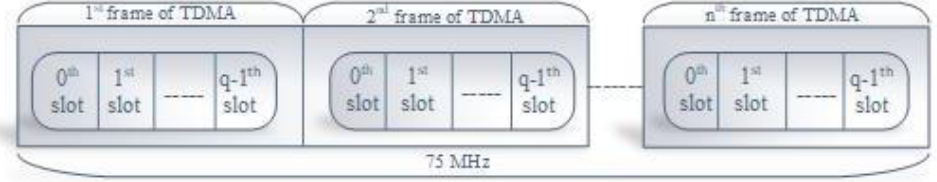
Figure 4. TDMA frame